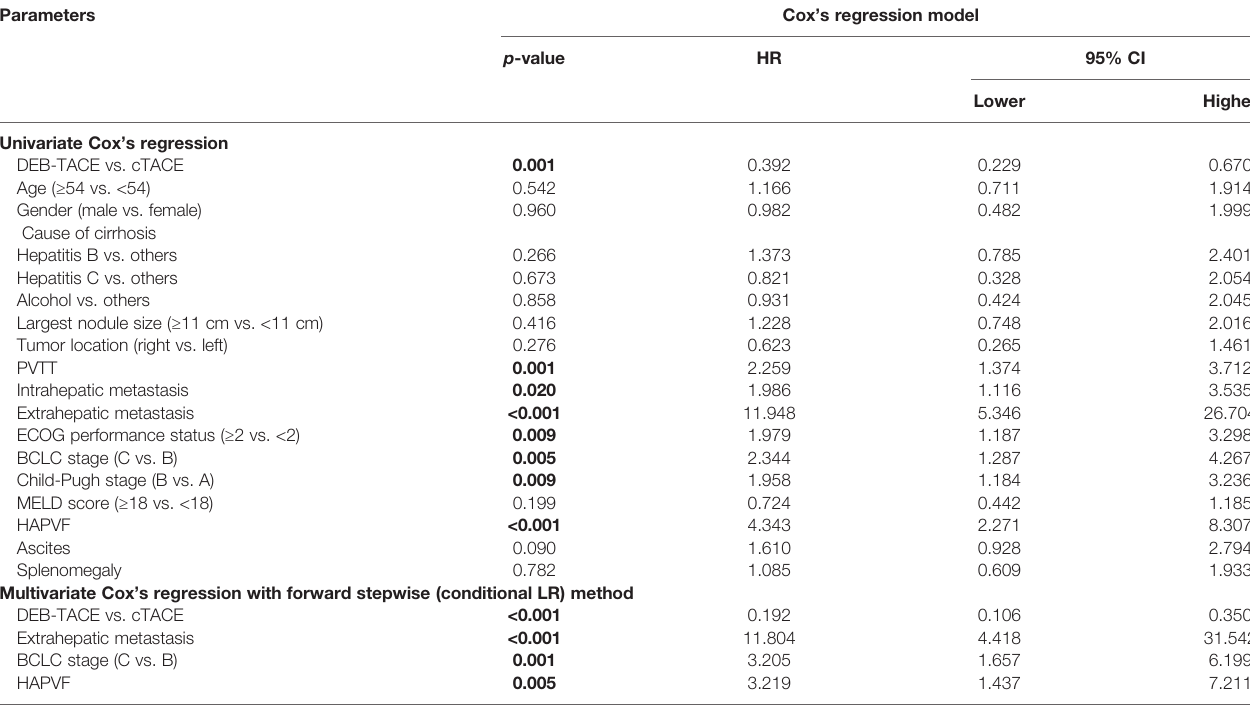
TABLE 2 | Factors affecting PFS by Cox ’ s proportional hazards regression model